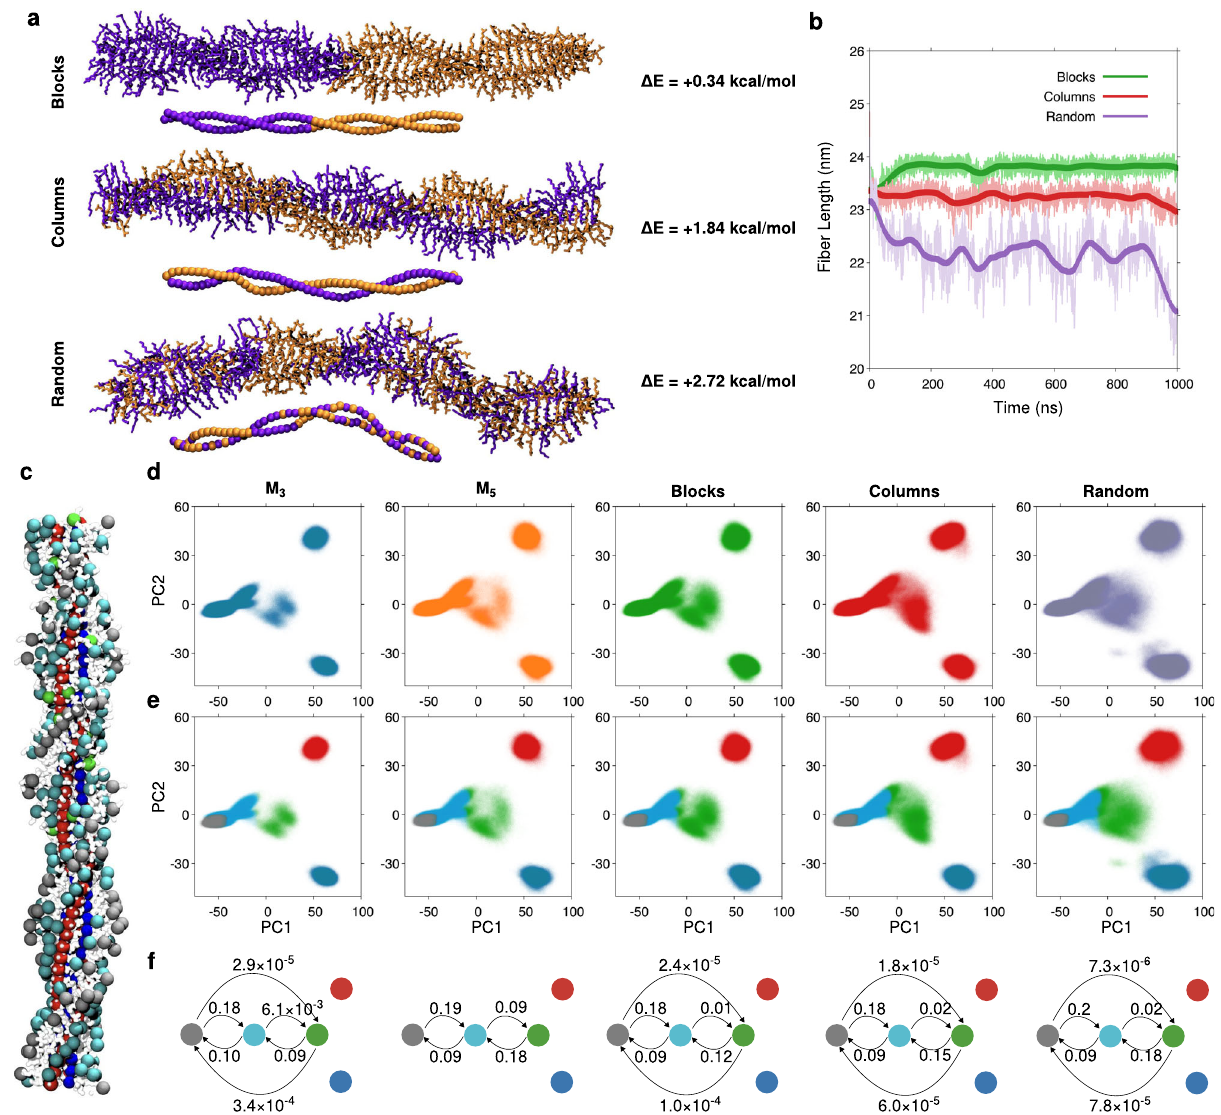
Fig. 7 Structure and dynamics of supramolecular block copolymers. a Equilibrated MD snapshots of M 3 - M 5 copolymers models where the M 3 (in orange) and M 5 monomers (violet) are arranged in blocks (top), into segregated M 3 and M 5 intertwining columns (middle), or randomly mixed in the fi ber (bottom). The arrangements of the fl uorinated cyclohexane centers are shown below the MD fi bers ’ snapshots. The energies of the different M 3 - M 5 mixing schemes relative to completely segregated M 3 and M 5 homopolymers ( Δ E) are reported beside each equilibrated copolymer model. b Length of the Blocks (in green), Columns (red) and Random (violet) copolymer models as a function of MD simulation time. c Structure of the Blocks fi ber colored based on the clusters (molecular motifs) identi fi ed by the SOAP-PAMM analysis: fl uorinated cyclohexane and amide groups in blue and red, the alkyl side chains of the monomers in gray, green and cyan 66,67 . d PCAs of the SOAP vectors for M 3 and M 5 homopolymers, and for Blocks, Columns and Random copolymers (left-to-right). e Unsupervised PAMM clustering of the PCA data ( d ): different colored clusters indicate different local structural/dynamic motifs in the fi bers. The closer and more interconnected are the colors (e.g., gray, cyan, green surface sites), the more dynamic is the interconnection between them (e.g., indicative of a dynamic surface). Separated clusters identify static, ordered, and persistent domains in the fi ber (e.g., red and blue clusters, indicative of a relatively static fi ber backbone). f Schematic representation of the dynamic transitions between the clusters estimated from the MD: the higher are the transition probabilities (numbers associated to the transition arrows), the more dynamic is the exchange between the clusters. No arrows indicate no exchange. The results show that these fi bers have an intrinsic dynamic diversity: with a dynamic surface, and a static and ordered interconnection between gray, cyan and green clusters (Fig. 7f) shows that in the same time-lapse there is dynamics on the surface of these fi bers. The rich dynamic nature of these fi bers is reminiscent of the innate dynamic diversity seen for also in other supramolecular polymers in solution 72,76 . Also, the growing interconnection between gray, cyan and green clusters going from left-to-right in Fig. 7f indicate that the surface of the fi bers becomes more dynamic and disordered going from homopoly- mers to increased M 3 - M 5 mixing within the copolymers.